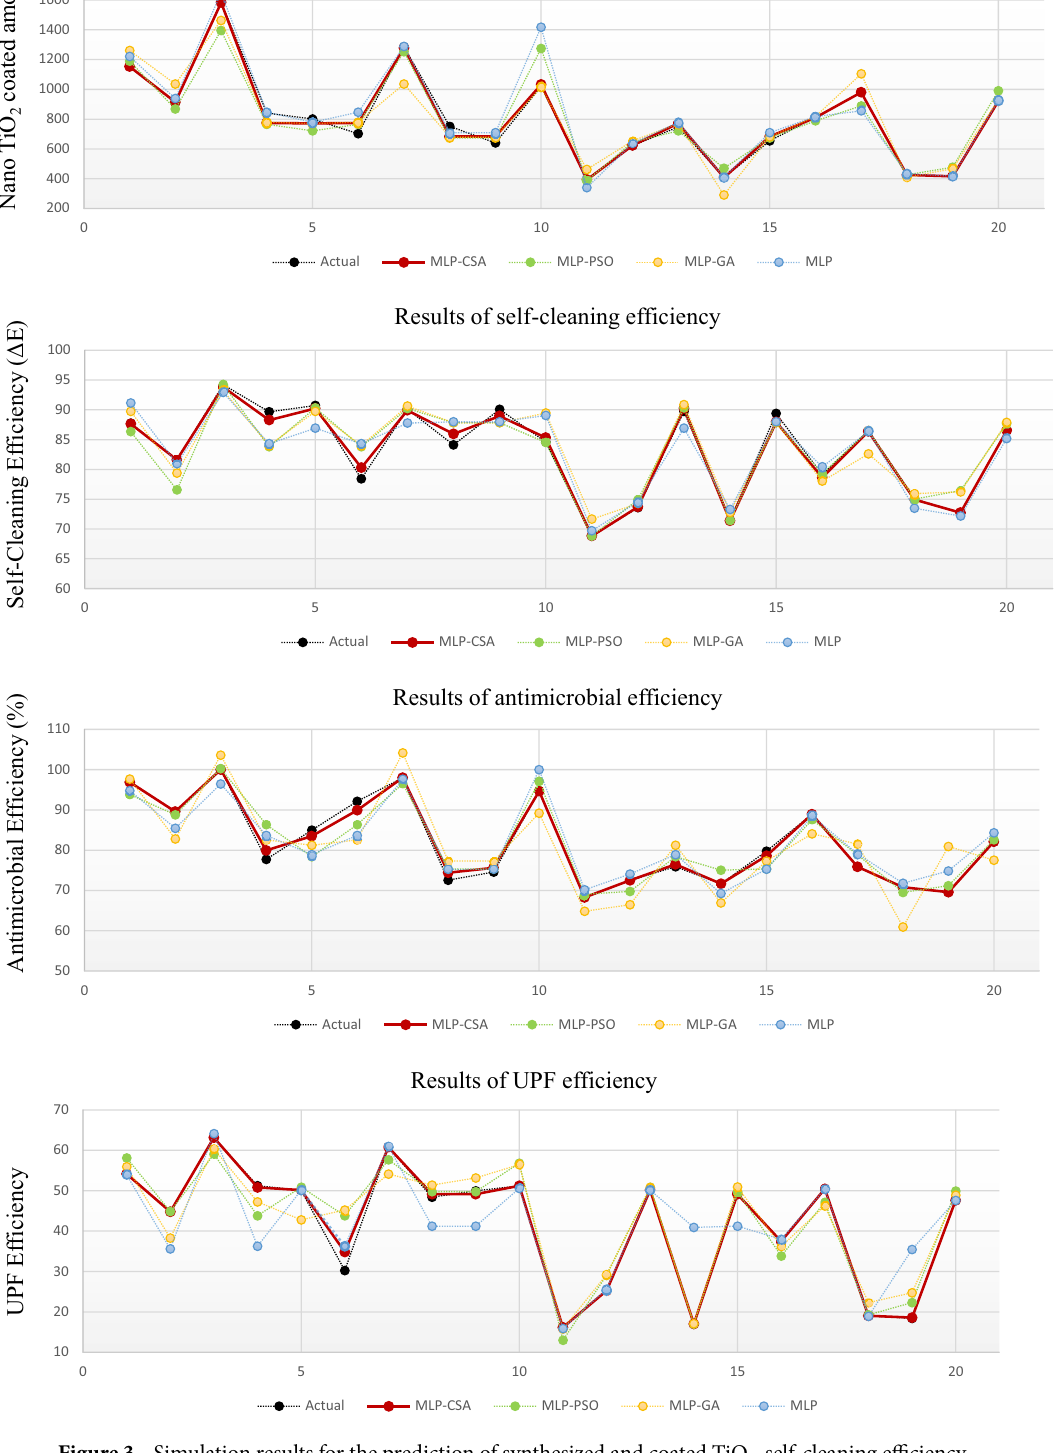
Figure 3. Simulation results for the prediction of synthesized and coated TiO 2 , self-cleaning efficiency, antimicrobial efficiency, and UPF efficiency using MLP-CSA, MLP-PSO, and